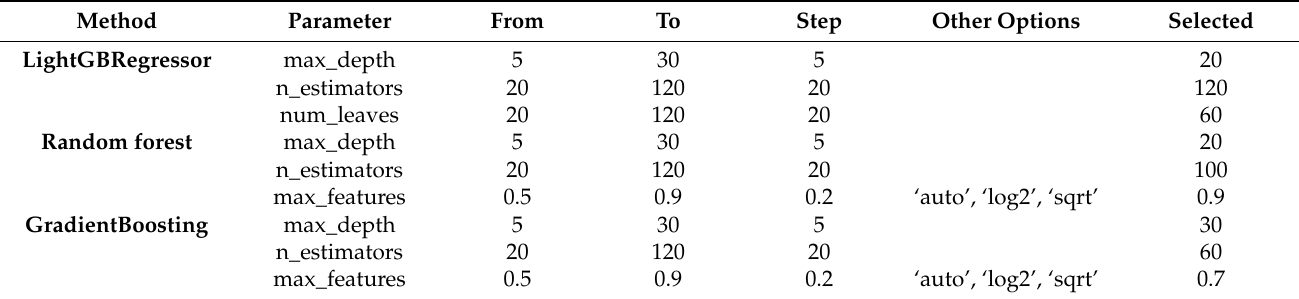
Table 2. Summary of model parameters used in evaluating machine-learning